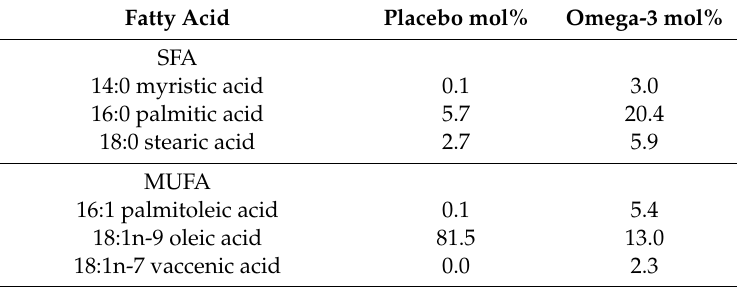
Table 1. Compositionoffattyacids(mol%oftotalfattyacids*)presentintheplaceboandomega-3capsules. Fatty